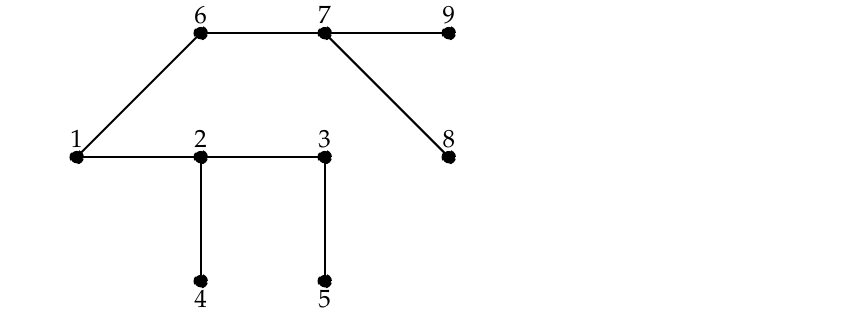
Figure 4. An alternative solution for the 9-bus system regarding optimal routes.